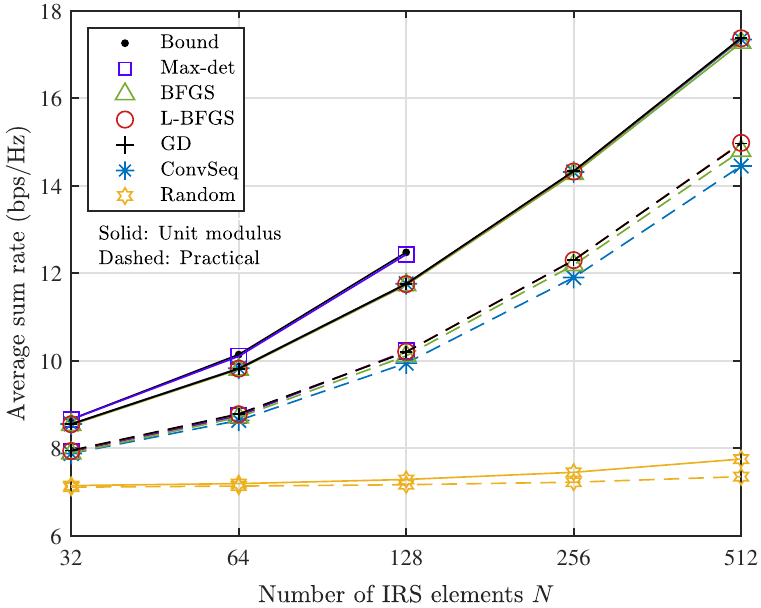
Figure 3. Average sum rate as the number N of IRS elements increases when M = 2 and K =